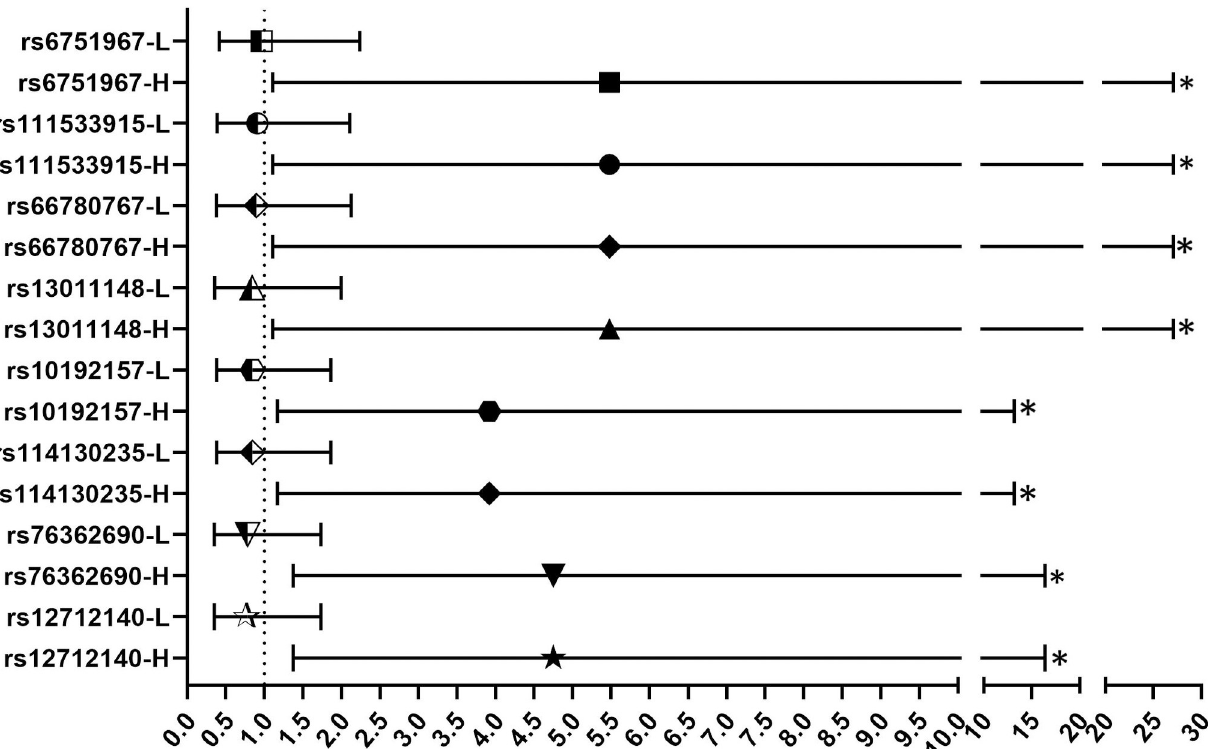
Fig 1. Adjusted association measurements, odds ratio (OR) and 95% confidence interval (95%CI), between the SNVs of the ST2 gene and periodontitis, through subgroup analysis, using the variable Aggregatibacter actinomycetemcomitans relative amount, showing the groups with high (H) and low (L) quantification of this bacteria in the biofilm and considering dominant genetic model. Adjusted for age, diagnosis of asthma, and PC1. � Statistical significance level: permutation p � 0.05.